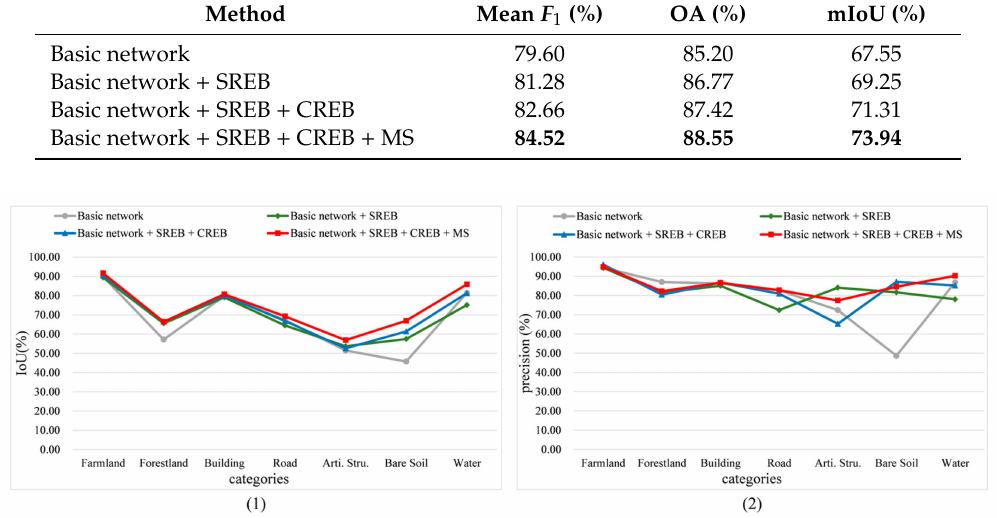
Table 3. Detailed performance of the proposed network with di ff erent settings. SREB: spatial relation-enhanced block; CREB: channel relation-enhanced block; MS: multiscale fusion module. The largest classification accuracy is highlighted in bold.